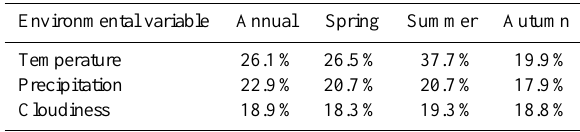
Table 5. Medians of the distributions of the relative partial signif- icant contribution ( R 2 – 95% significance) of each de-trended en- vironmental variable (except fire) of each season to the interannual variability in de-trended annual GPP (GPPsat). In each case the to- tal contribution may not add up to 100%. In these cases the factors behind the unexplained attribution are not